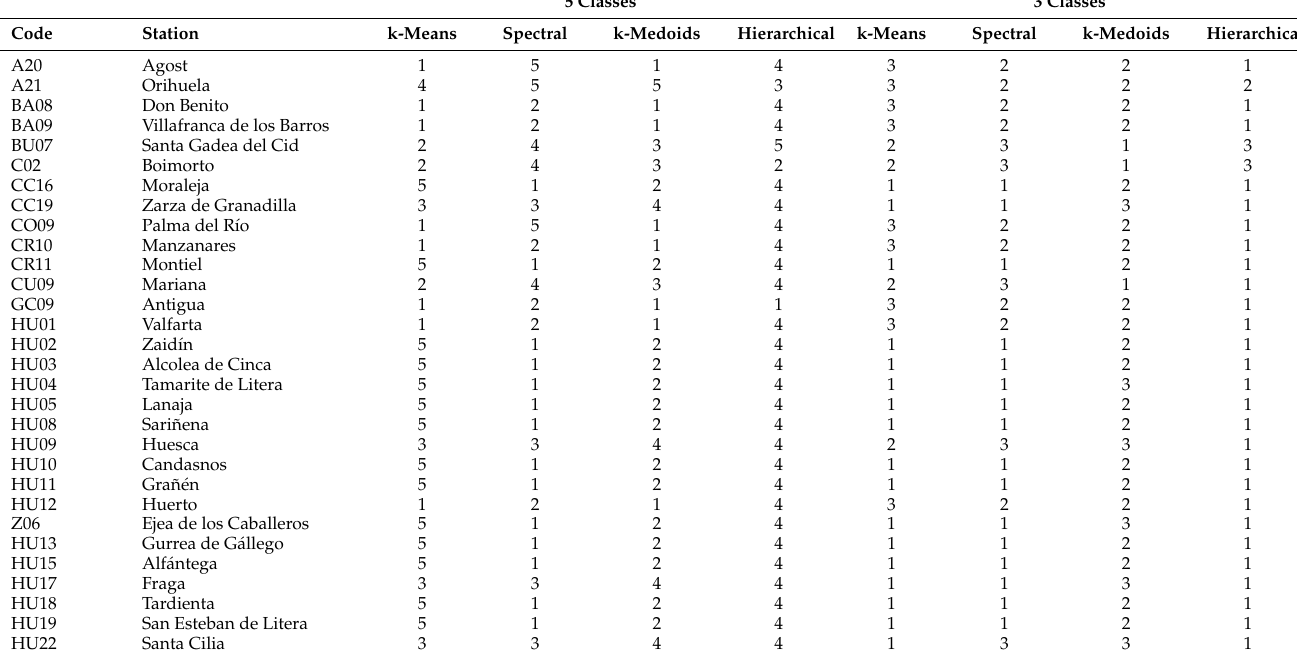
Table A2. Clustering by method and number of